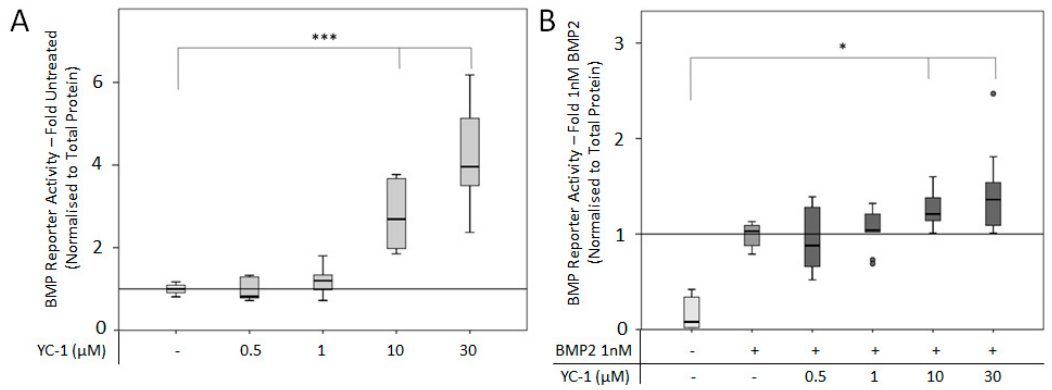
Figure 8. BMP reporter activity following NO independent activation of sGC: C2C12BRELuc reporter cell line stimulated for 24 h in DMEM without Arginine with ( A ) 0.5-30 µ M YC-1 and ( B ) in combination with 1 nM BMP2. Statistics: Kruskal–Wallis Test followed by Mann-Whitney U test. Mann-Whitney U test significances between samples were assigned if p < 0.05 (*) or p < 0.001 (***). Circles are outlying values. Replications ( A , B ) n = 9.